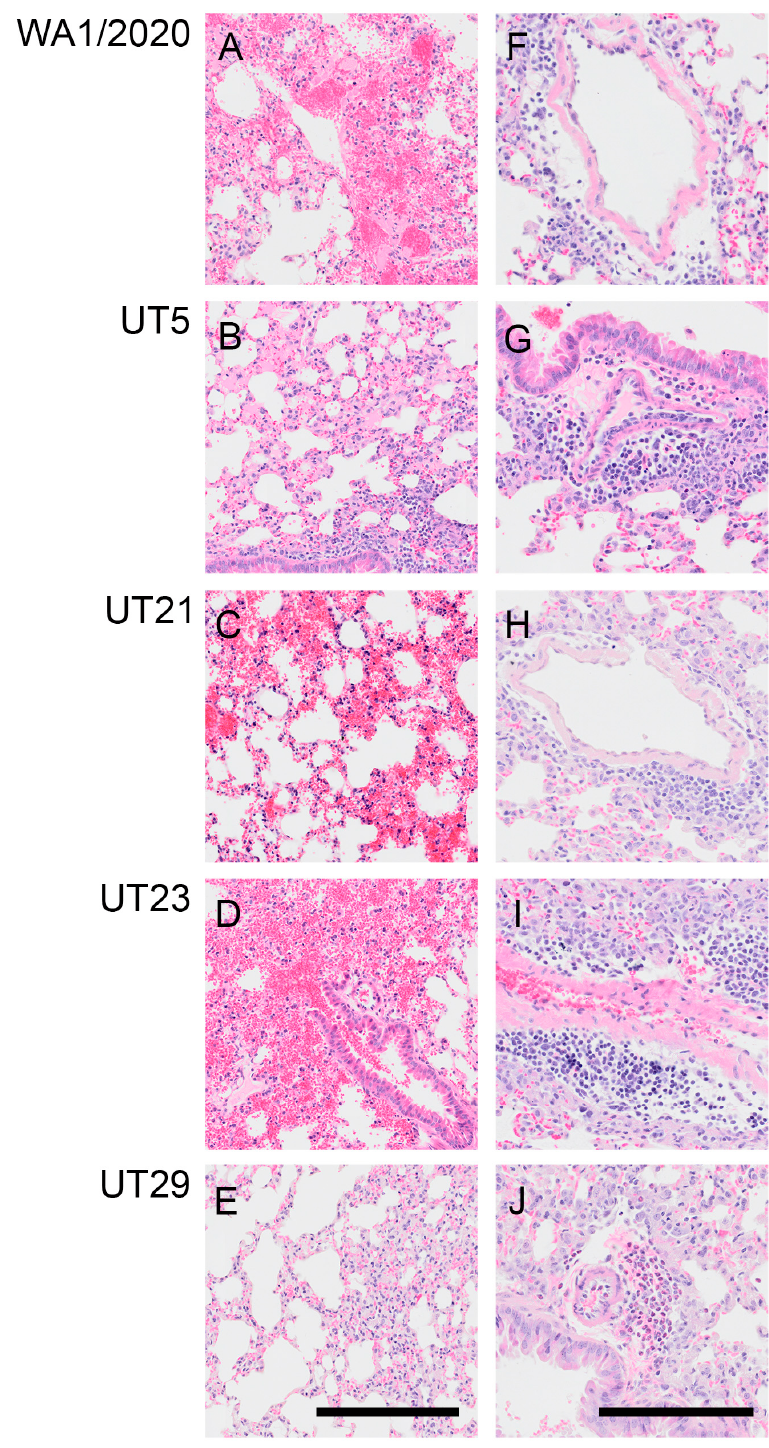
Figure 5. Representative images showing hemorrhage or perivascular inflammation in lungs of K18-hACE2 mice infected with WA1/2020, UT5, UT21, UT23, or UT29 at 5 DPI. Representative images of H&E-stained lung sections showing hemorrhage and necrosis from mice infected with WA1/2020 ( A ), UT21 ( C ), and UT23 ( D ). No hemorrhage was seen in UT5 ( B ) or UT29 ( E ). Lungs from UT5-infected mice showing vascular leakage ( B ) and monocyte infiltration ( G ). Representative images of lung sections with perivascular inflammation and edema characterized by infiltration of mononuclear cells from mice infected with WA1/2020 ( F ), UT5 ( G ), UT21 ( H ), UT23 ( I ), or tissue eosinophils in mice infected with UT29 ( J ). Edema is noted in ( F , I ). Scale bar = 25 µ